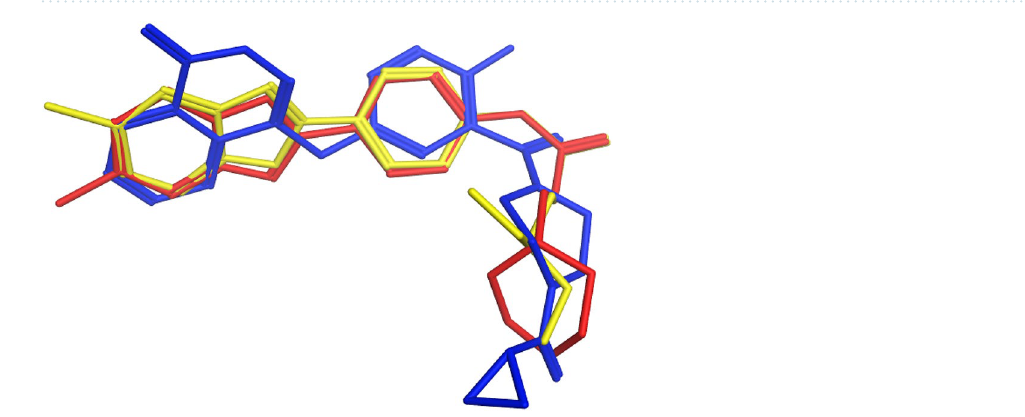
Figure 15. Flexible alignment of the most potent PARP-2 inhibitors 12 (red), 27 (yellow) and olaparib